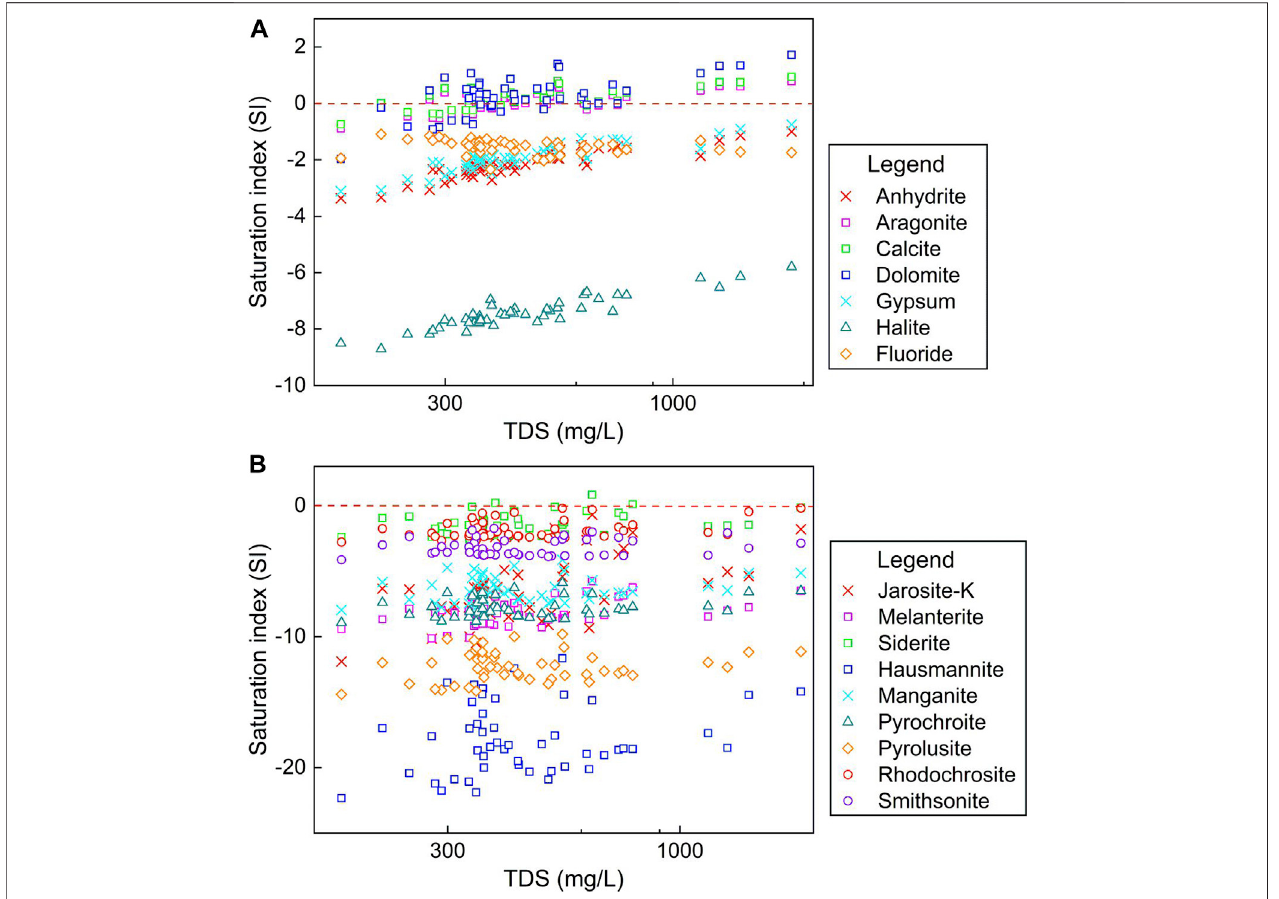
FIGURE 6 | Saturation index simulation results of typical minerals for phreatic groundwater.